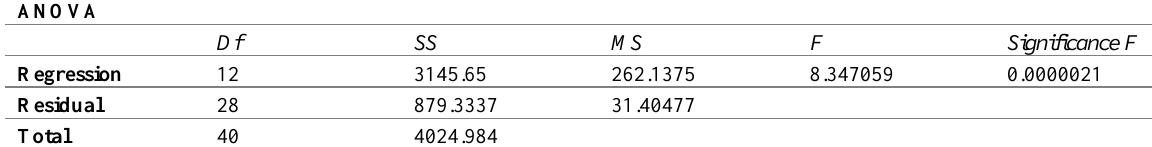
Table 5: ANOVA (Barisal Division)